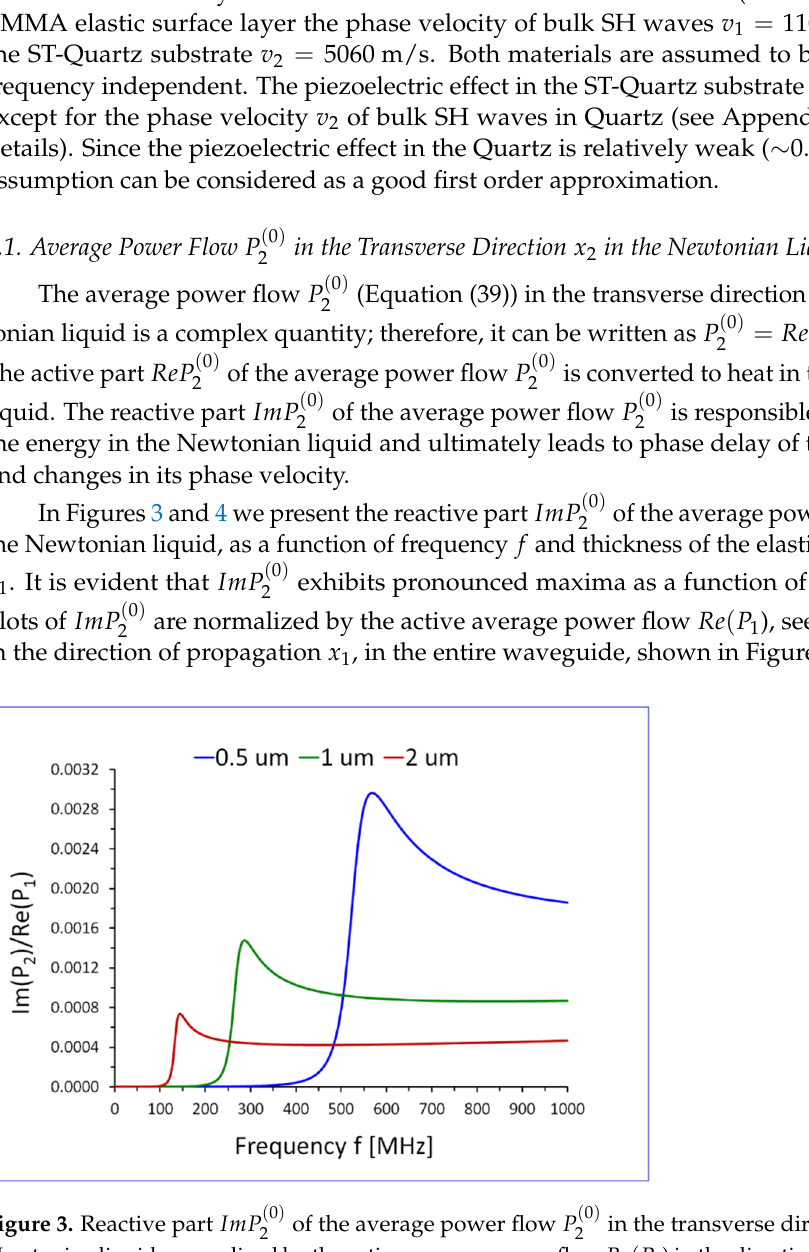
Table 1. Material and geometrical parameters of the Love wave waveguide.